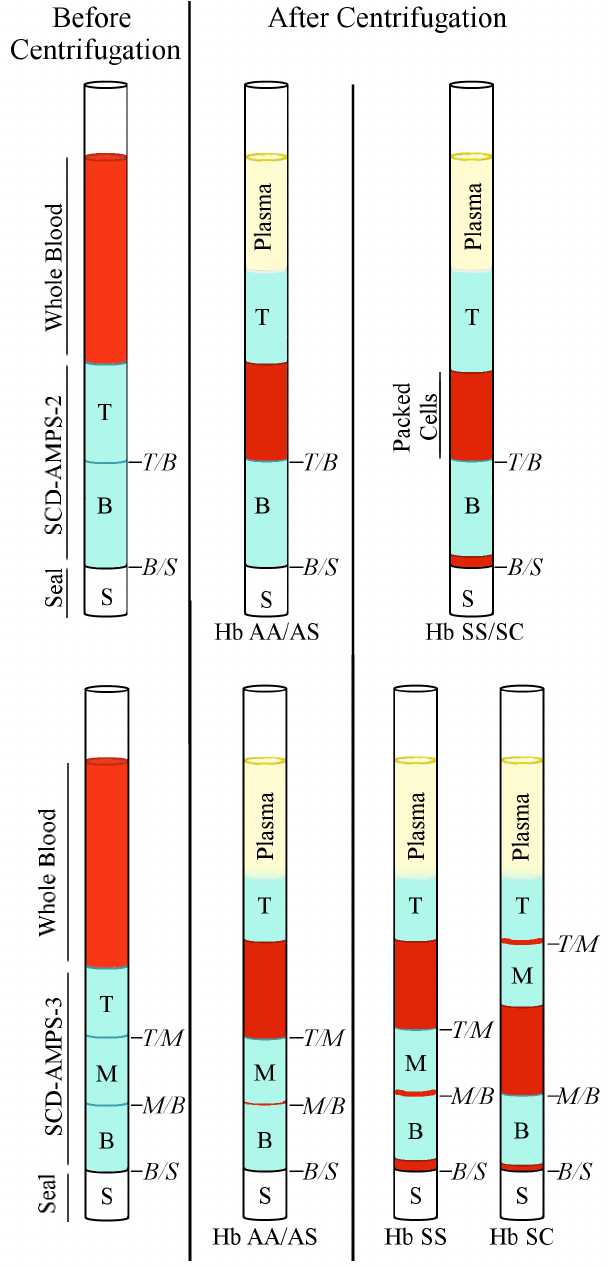
Fig. 1. Schematic of the density-based tests to identify SCD. Both versions of the SCD-AMPS are designed to separate dense red blood cells present in SCD from whole blood. Blood passes through the phases—top (T) and bottom (B) for SCD-AMPS-2 and top (T), middle (M), and bottom (B) for SCD-AMPS-3— upon centrifugation. If sickled cells are present, they collect at the interface between the bottom phase and the seal ( B/S ), and provide a visual readout for the presence of SCD. In SCD-AMPS-3, the additional phase allows the discrimination of Hb SS from Hb SC by evaluating the distribution of red cells at the upper interfaces (between the top and middle phases ( T/M ) and the middle and bottom phases ( M/B